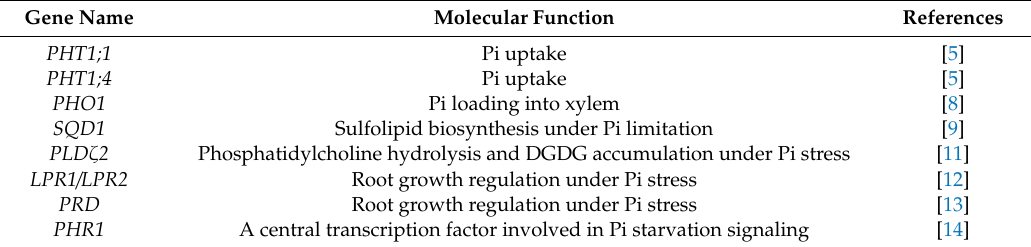
Figure 8. E ff ects of di ff erent phosphate (Pi) concentrations on the dry weight and endogenous Pi levels of the OE BnaA7.CRF8 lines and Col-0 plants. Eleven-day-old OE BnaA7.CRF8 lines and Col-0 plants grown on 50 and 1000 µ M Pi were imaged for measurement of the dry weight ( a ) and endogenous Pi levels ( b ). Values represent mean ± SD, n = 4 replicates of 20 seedlings each. Small letters (a, b, and c) above the bars indicate mean with significant di ff erences at p < 0.05 by Duncan’s test.